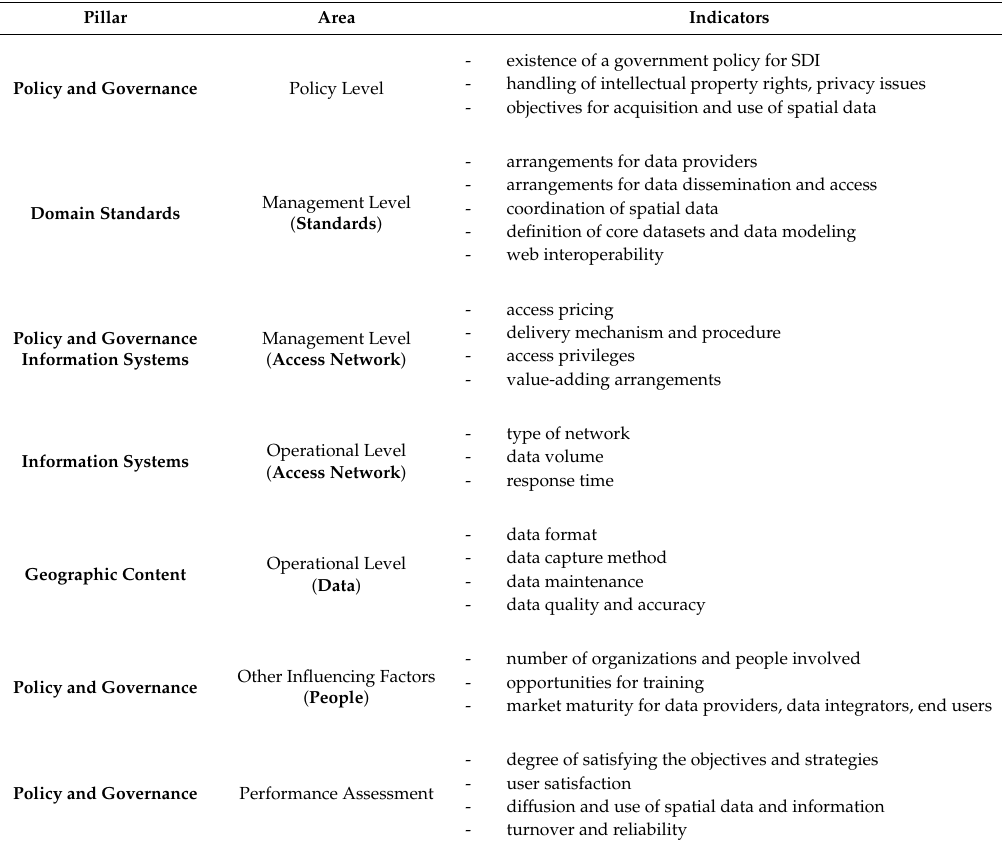
Table 6. Indicators for evaluating SDIs. Adapted from reference [55].